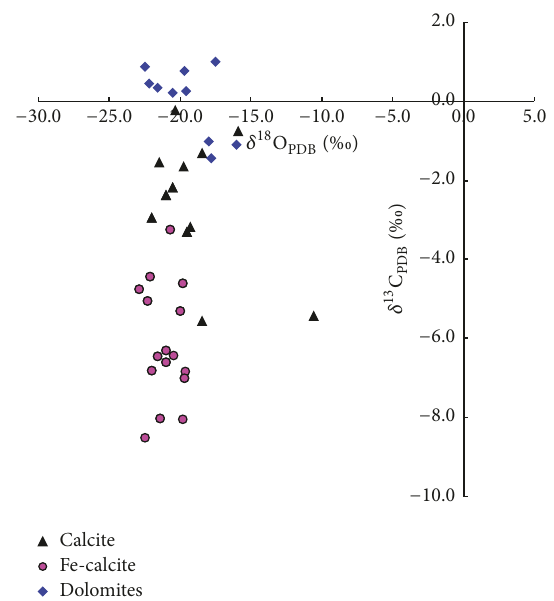
Figure 8: Scatter diagram showing the oxygen versus carbon stable isotopes for all types of carbonate cement of Yanchang Formation sandstones in Ordos basin (after